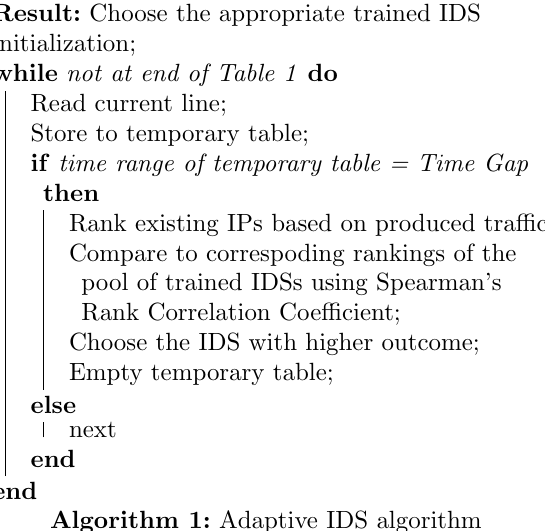
Algorithm 1: Adaptive IDS algorithm